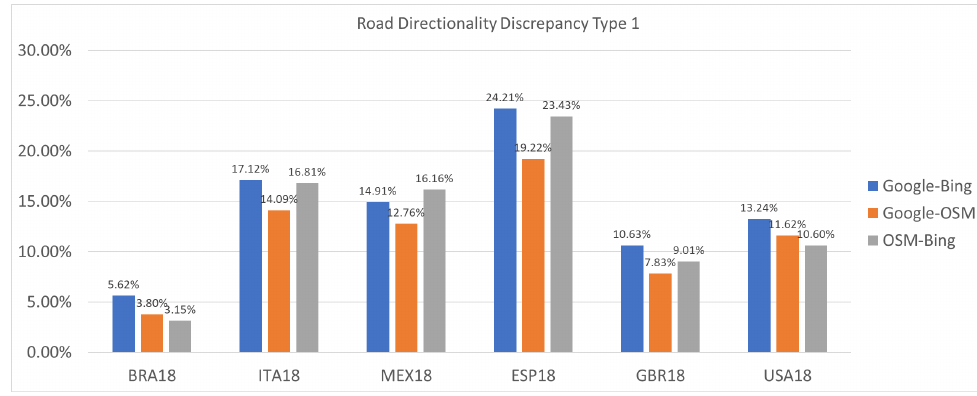
Figure 17. Road direction discrepancy stats Type 1 (weak